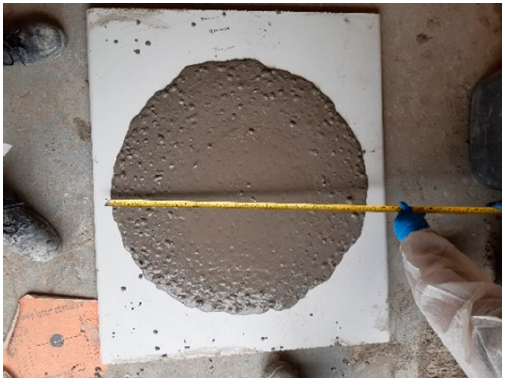
Figure 2. Slump flow of SCGC .